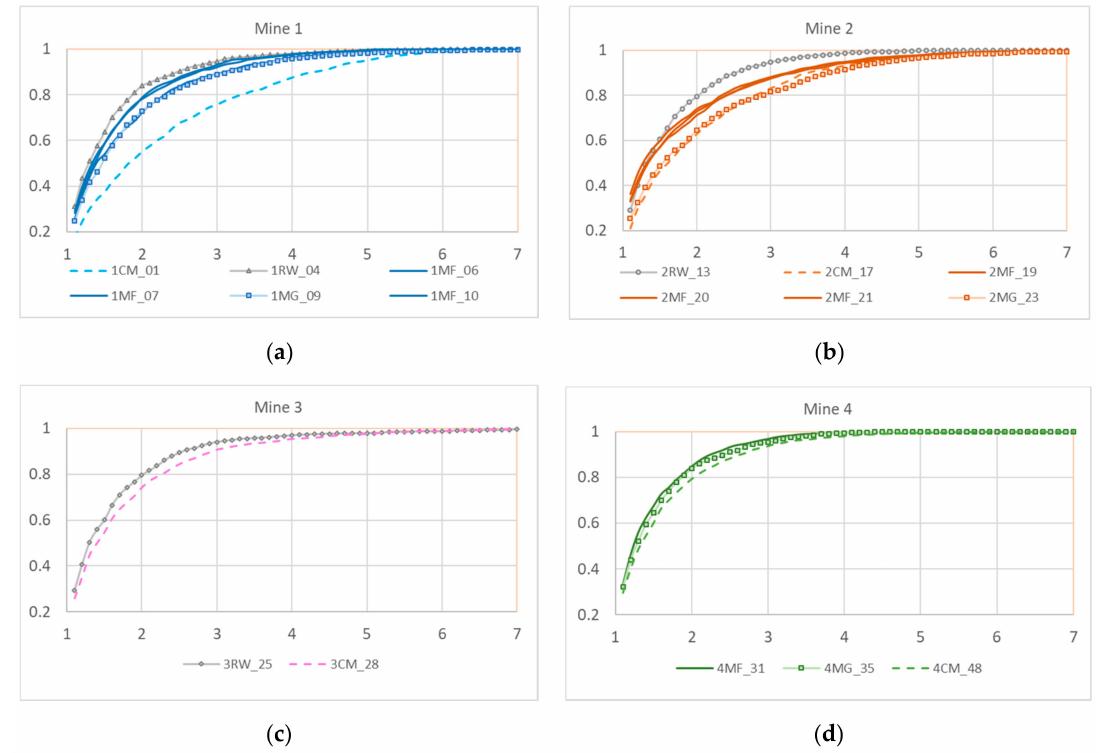
Figure 3. Cumulative particle size by sample. ( a ) Mine 1 samples, ( b ) Mine 2 samples, ( c ) Mine 3 samples and ( d ) Mine 4 Sammples. X-axis = particle size (microns) and y-axis = cumulative percentage.